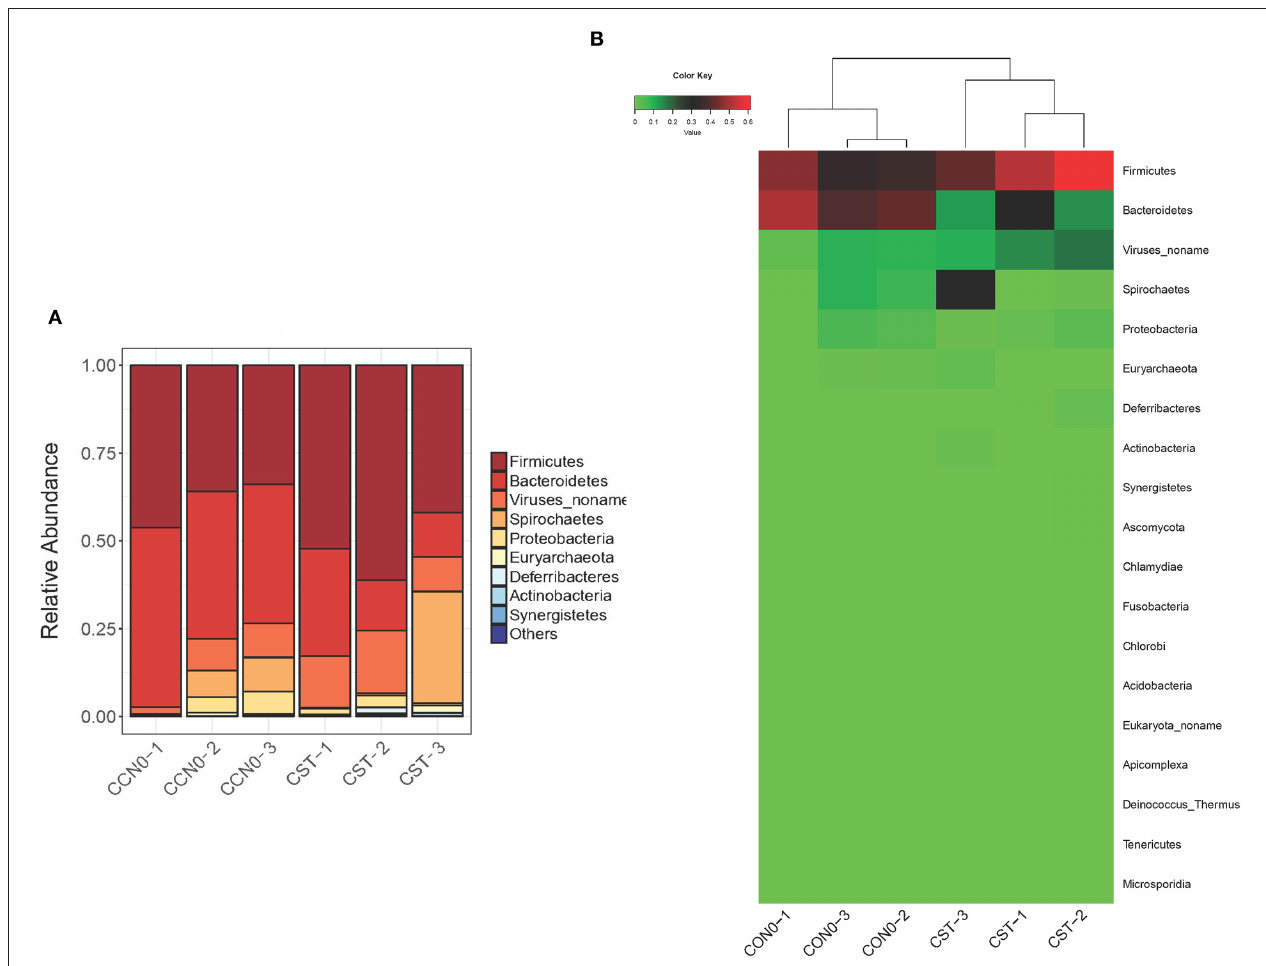
FIGURE 4 | Effects of colistin on microbiome composition changes at the phylum level displayed as a bar chart (A) and a heatmap (B) . The abundance of phyla is shown on the y axis. Group 1, control group; group 2, colistin group.